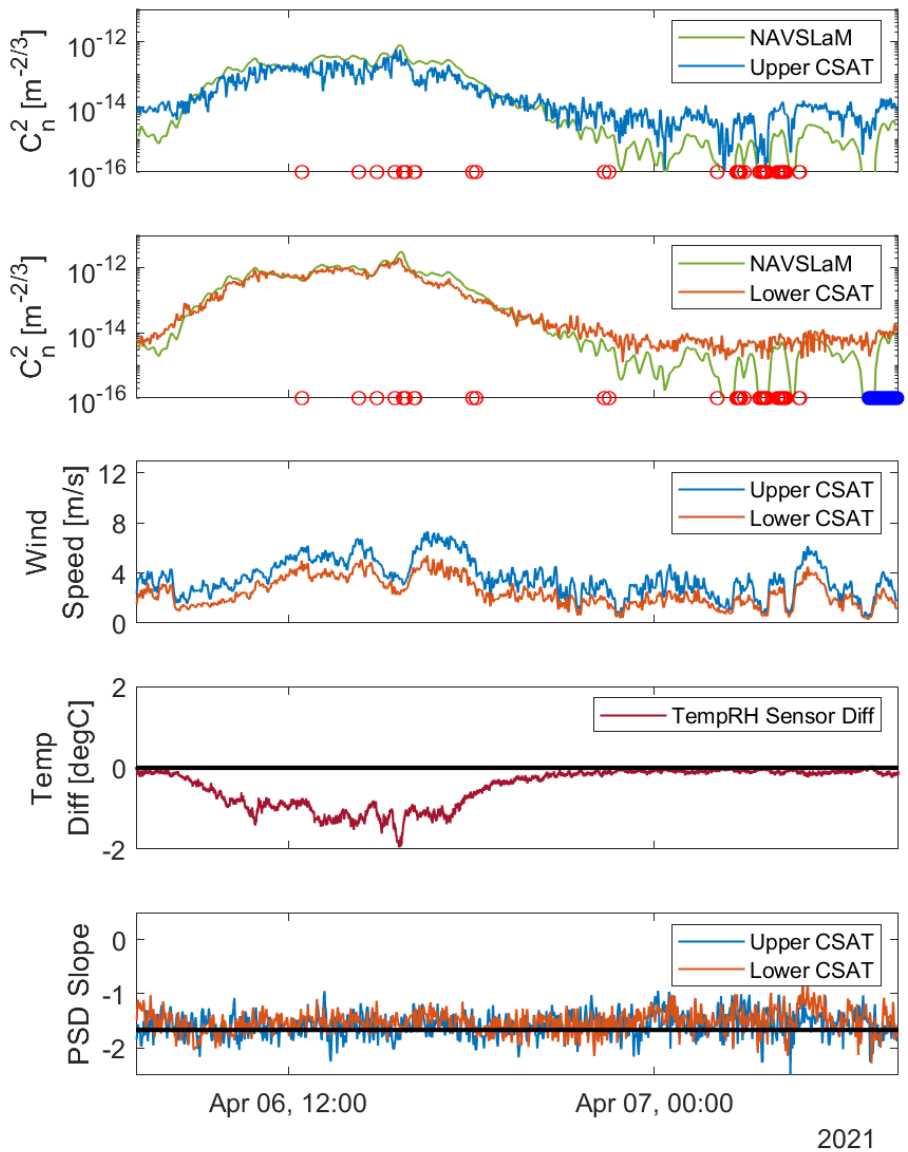
Figure 5. Comparison between C 2 n derived from the CSAT3 data to NAVSLaM derived estimates, from 0700 Tuesday, 6 April to 0800 Wednesday, 7 April. The wind speed recorded from each CSAT3, the temperature difference between the CSAT3 positions, and the slope of the PSD are also provided. The red and blue circles along the axes of the upper two plots indicate times when the sonics returned diagnostic errors, as discussed in the text.